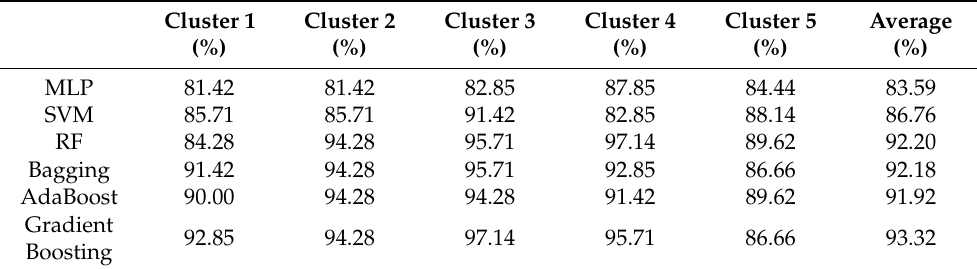
Figure 5. Correlation matrix heatmap for selected features. Table 5. K-fold Cross-Validation Accuracy Prediction For Six